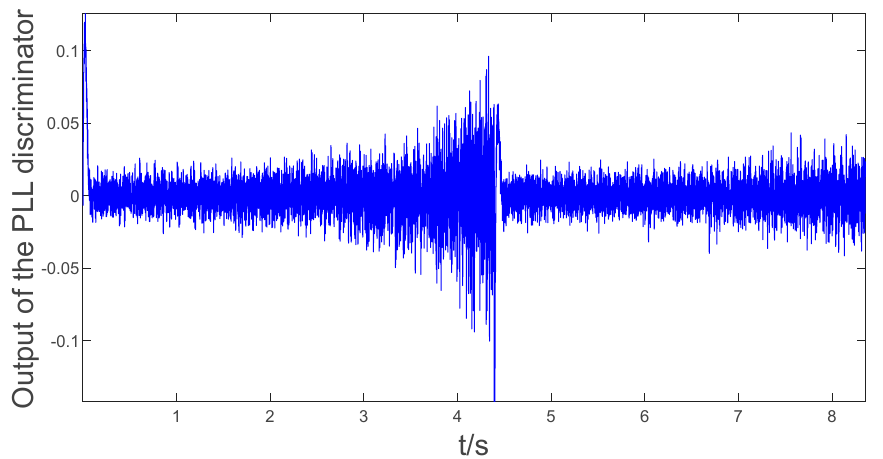
Figure 19. Output of the carrier loop discriminator of simulation signal.